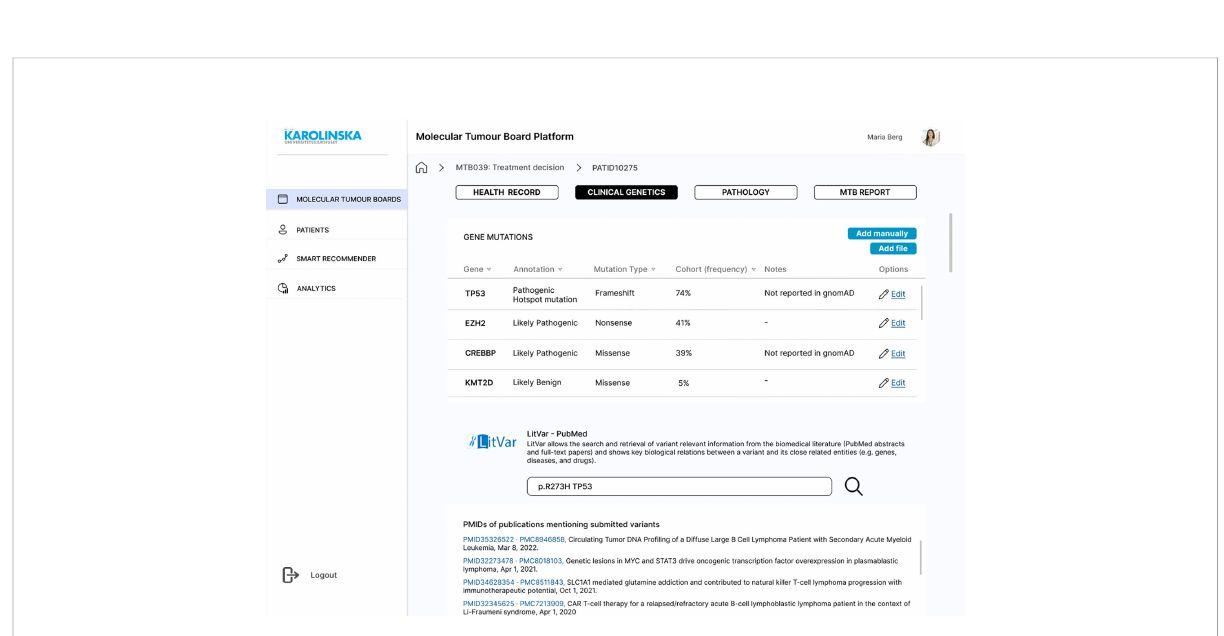
FIGURE 8 Mock-up screen. Clinical genetics information and LitVar